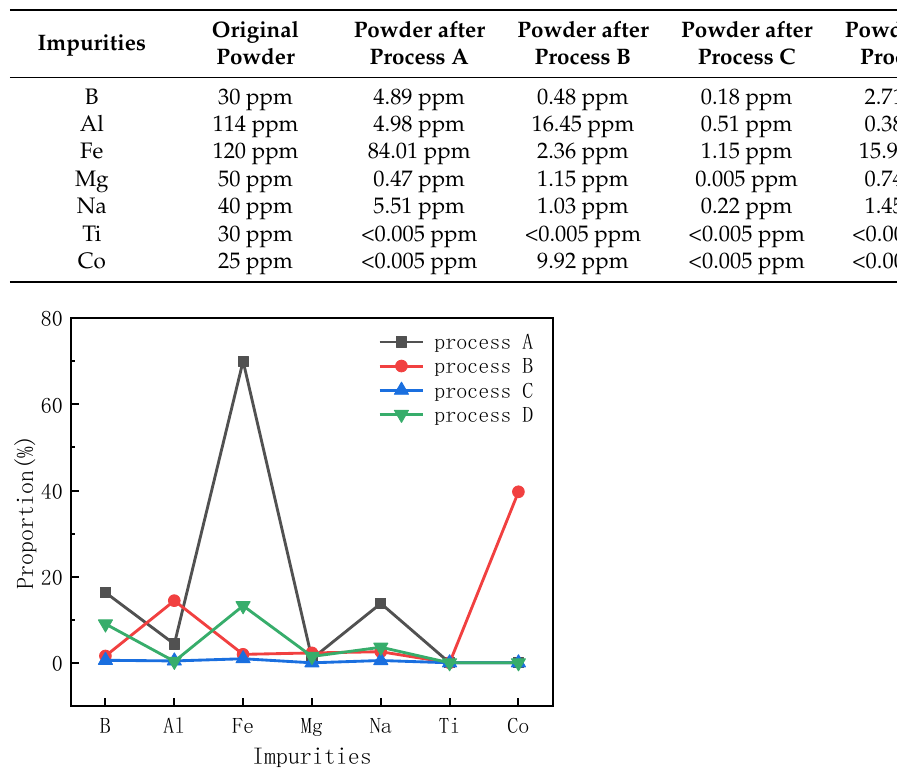
Table 1. GDMS data of different powders.